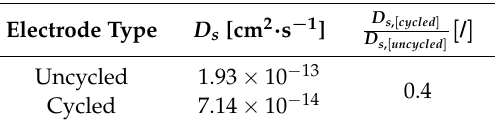
Table 7. Diffusion coefficients in uncycled and cycled electrodes at 3.71 V determined by EIS and their diffusivity